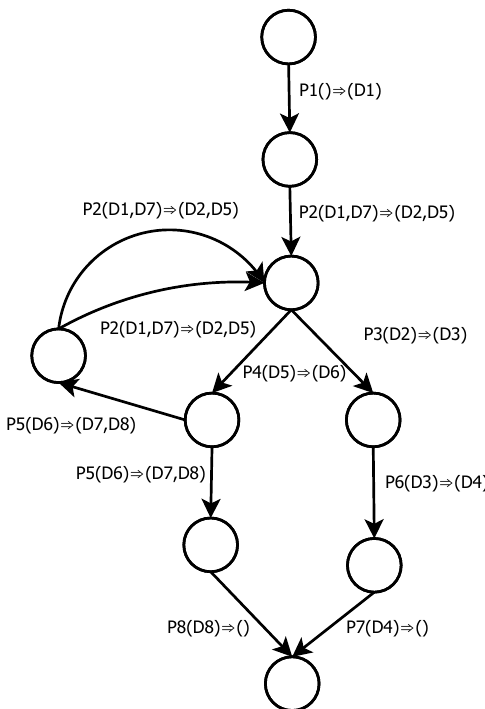
Fig. 16. Application result of Duplicate Outgoing Edge Elimination